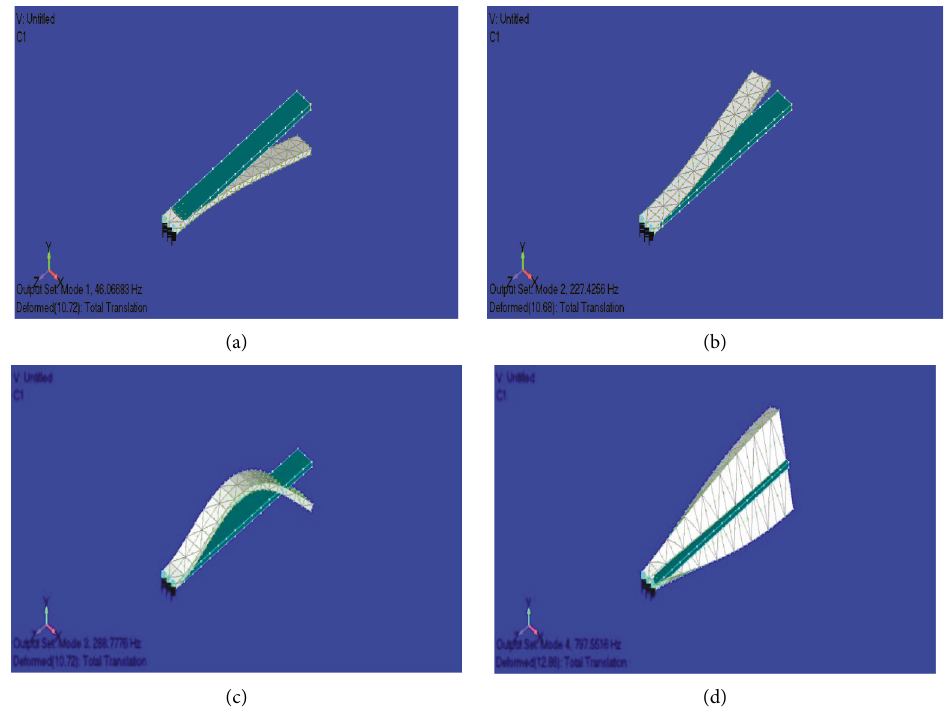
Figure 12: Vibration analysis of 60/40% glass/epoxy composite plate. (a) Mode 1, (b) Mode 2, (c) Mode 3, (d) Mode 4.